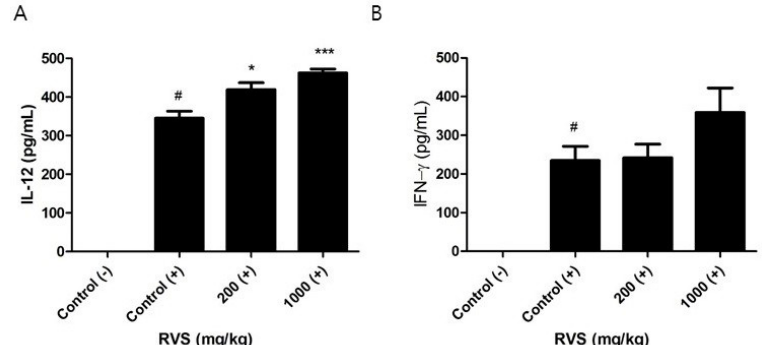
Figure 6. Effects of RVS extract on IL-12 and IFN- γ levels in the supernatants of LPS-stimulated peritoneal macrophages. Adherent peritoneal macrophages were stimulated with LPS for 24 h, and the concentrations of IL-12 ( A ) and IFN- γ ( B ) were measured. The bars represent the mean ± SEM ( N = 6). Statistical differences between groups were determined using one-way ANOVA with Tukey’s test. (-): without LPS, (+): with LPS. # p < 0.005 vs. control (-). * p < 0.5, *** p < 0.005 vs. control (+).